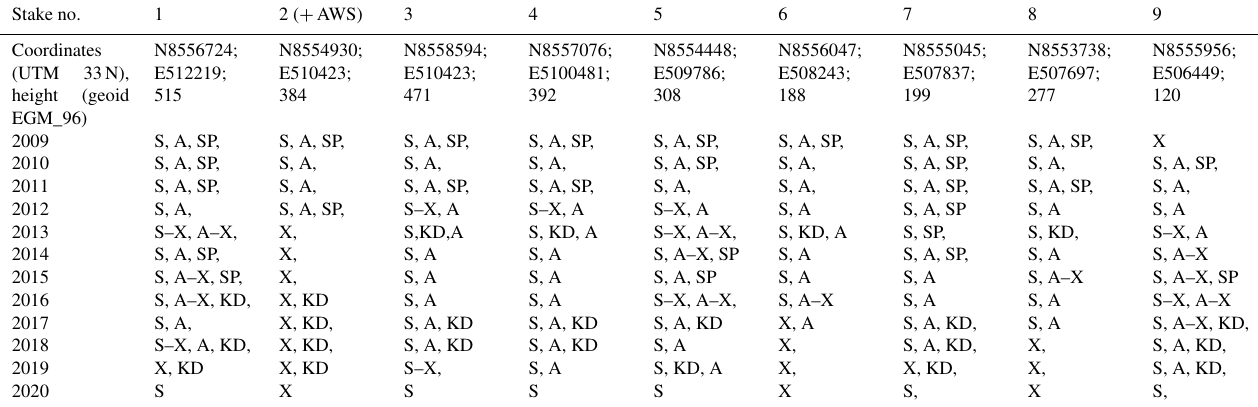
Table 2. Overview of mass balance and snow cover measurements on ablation stakes and infrastructure maintenance for the years 2009– 2020 on Werenskioldbreen (Svalbard). S: spring campaign (winter balance, April–May); A: autumn campaign (summer balance, August– September, can be performed next year spring); X: lack of stake; SP: snow pit (SWE data); KD: ICS drilling (SWE